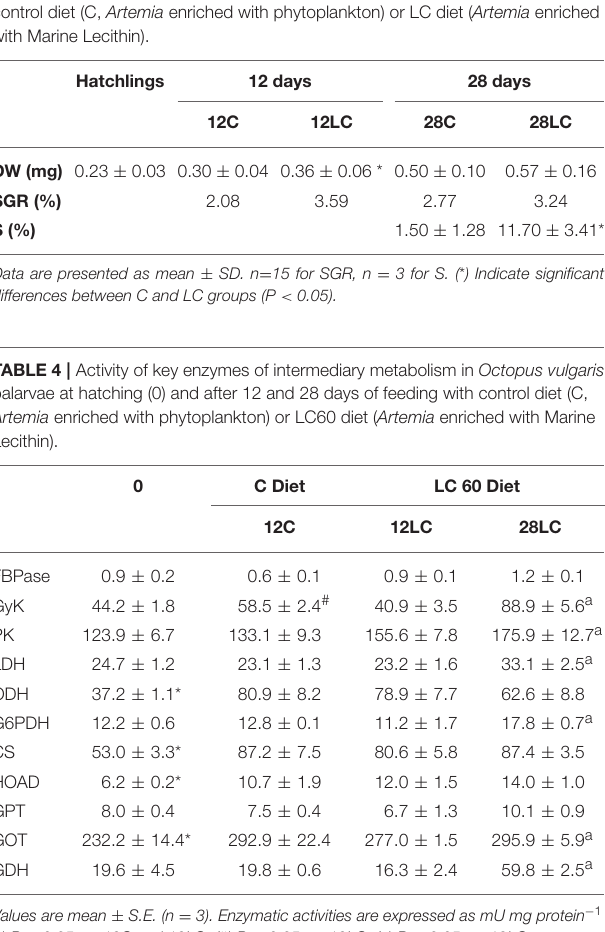
TABLE 3 | Dry weight (DW), specific growth rate (SGR), and survival (S) in common octopus paralarvae at hatching and reared for 12 and 28 days with